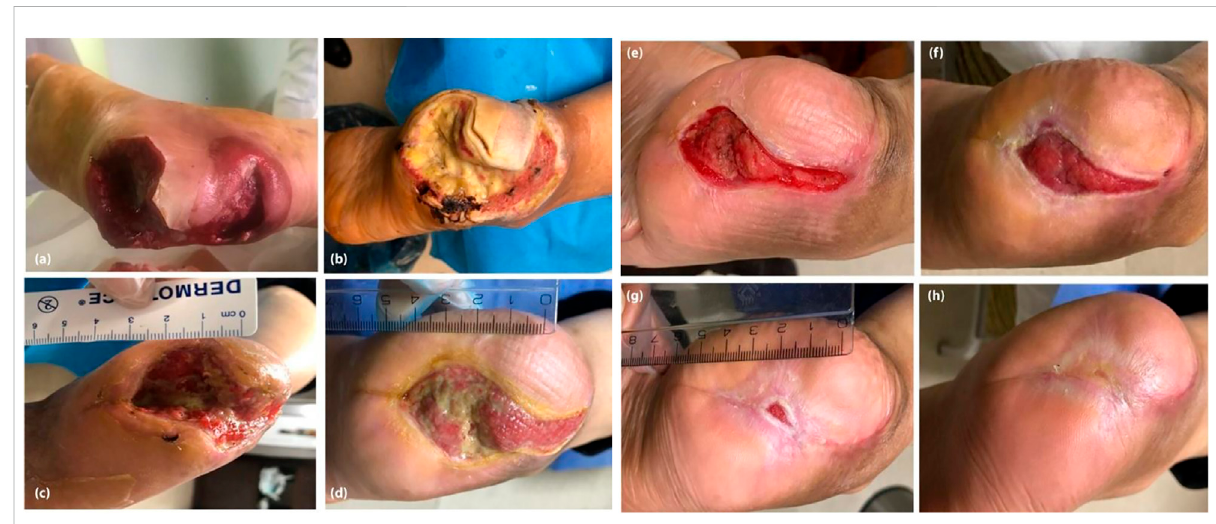
FIGURE 2 The patient before treatment (A) , 1 month (B) , 2 months (C) , 3 months (D) , 4 months (E) , 5 months (F) , 6 months (G) , and 7 months (H) after treatment. Reproduced with permission from Nilforoushzadeh et al. (2021). Copyright © 2020 The